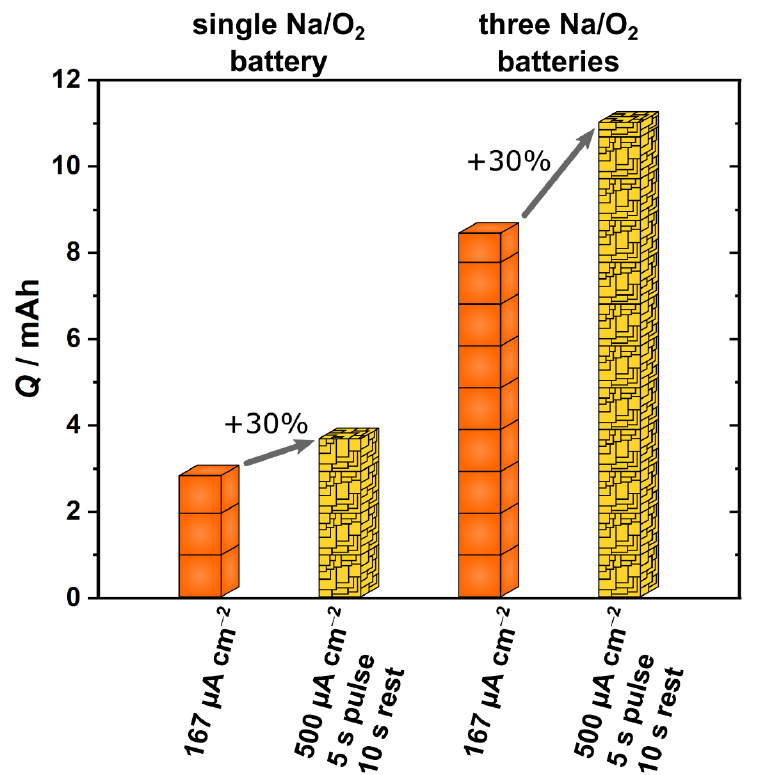
Figure 4. Comparison of discharge capacities obtained with continuous discharging and pulse discharging. The settings for discharging were chosen to address two parallel circuit settings, each containing three Na/O 2 batteries with an incoming and outgoing current density of 500 µA cm −2 for these two setups. While the current density stays at 500 µA cm −2 for the battery during pulse discharging, the current density is split between the three batteries during continuous discharging, thus resulting in a current density of 167 µA cm −2 for each individual battery.